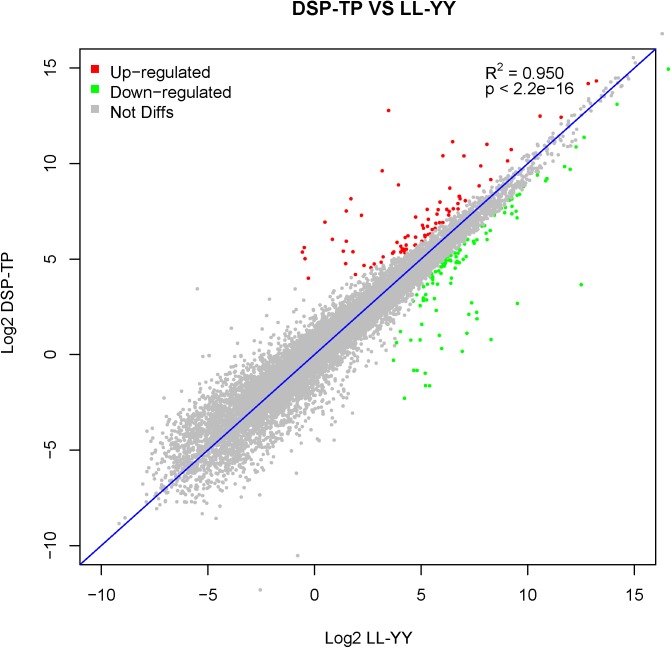
Comparison of the transcript expression levels between the Diannan Small-ear pig-Tibetan pig (DSP-TP) and Landrace-Yorkshire pig (LL-YY) groups.The vertical axis represents the Log2 fragments per kilobase of exon length million mapped reads (FPKM) in the DSP-TP group, and the horizontal axis represents the Log2 FPKM in the LL-YY group. The differentially expressed genes (DEGs) were filtered using P ≤ 0.05 and |log2ratio| ≥ 1 as a threshold. The red points represent upregulated genes, and the green points indicate downregulated genes. The gray spots represent no significant difference between the DSP-TP and LL-YY groups.